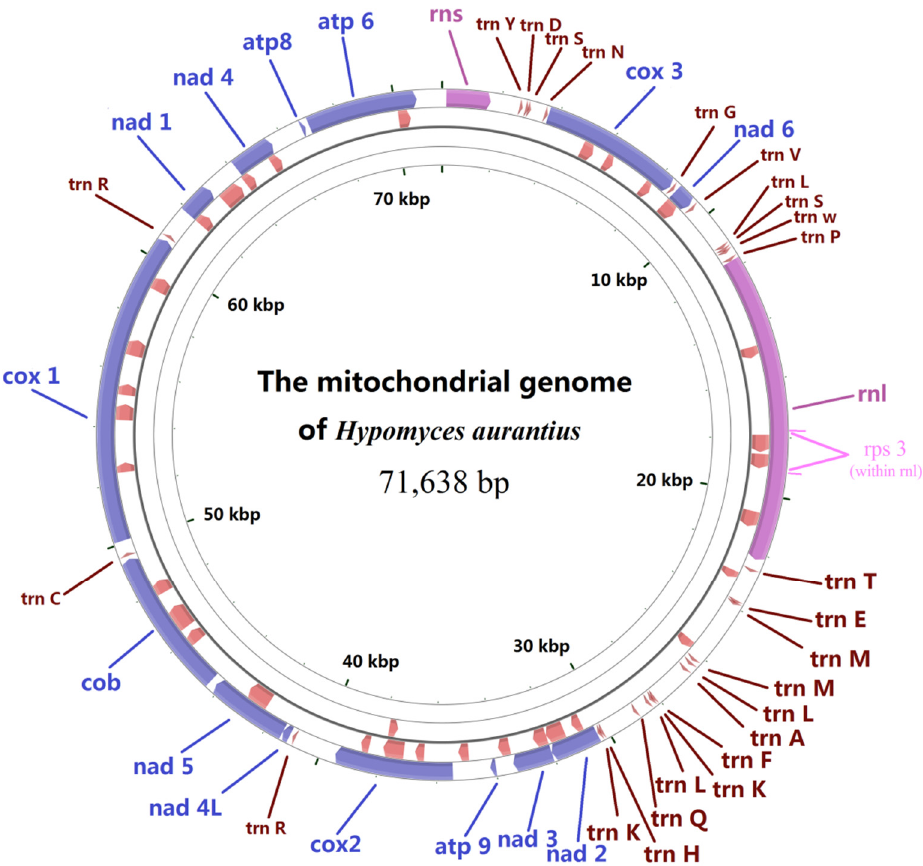
Figure 1. Physical circular map of the mitochondrial genome of Hypomyces aurantius H.a0001. The first nt of the rns gene was defined as nt 1 of the genome artificially. From outside to inside, the first ring represents genes encoding core proteins (blue), rRNAs (pink), and tRNAs (red); and the second ring represents the predicted ORFs (red) with clockwise direction; third ring represents the predicted ORFs (red) with anticlockwise direction. The name of each gene is indicated in its central region. The physical map was drawn using the program CG View [25].